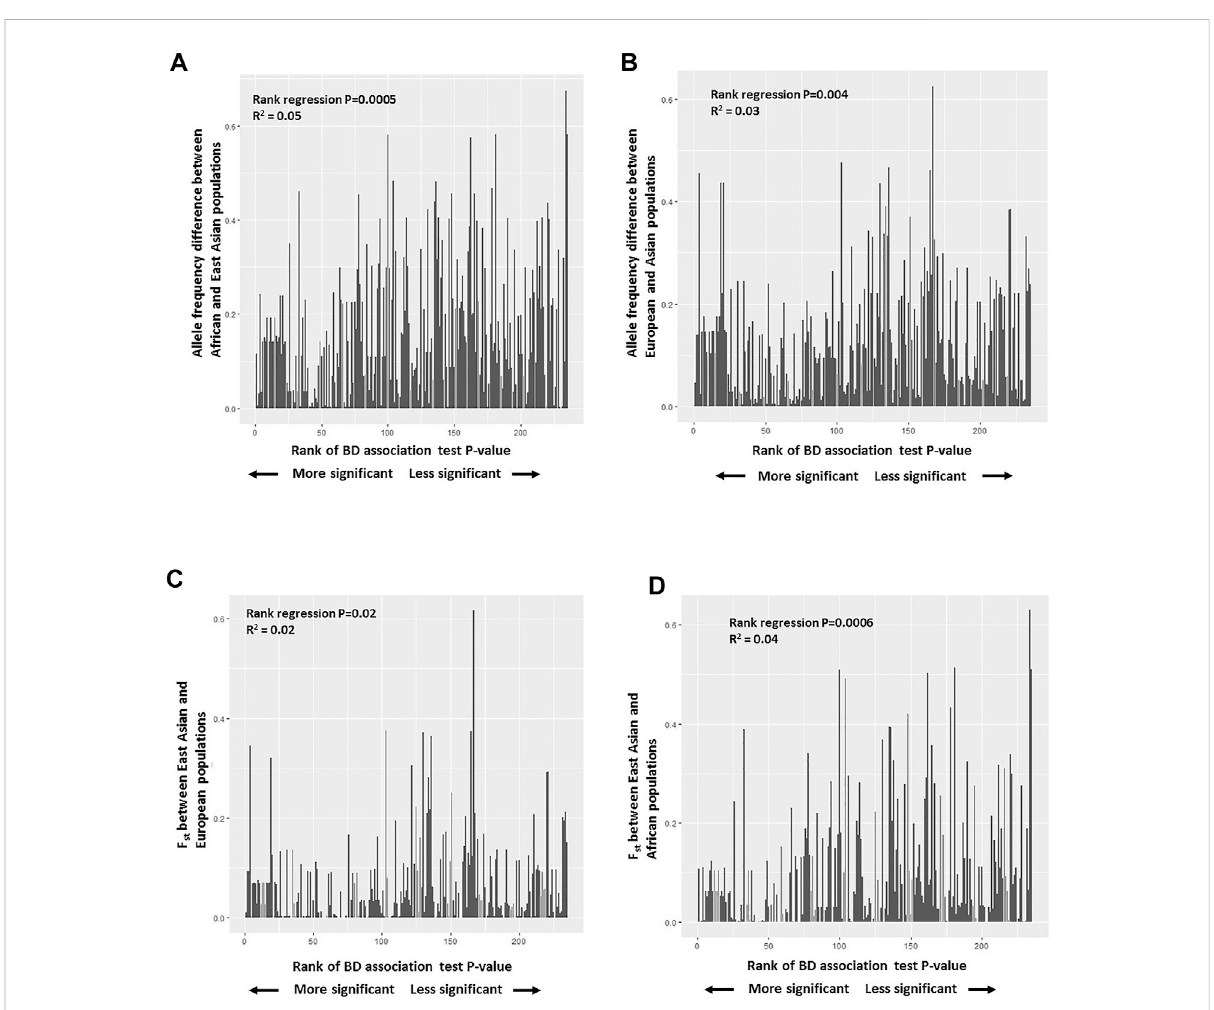
FIGURE 3 (A) Plot of BD associated variants ’ allele frequency difference between African and East Asian populations versus therank of BD association test p -valuesreported. (B) PlotofBDassociatedvariants ’ allelefrequencydifferencebetweenEuropeanandEastAsianpopulationsversustherank ofBD association test p -values reported. (C) Plot of population differentiation (F st ) between East Asian, and European populations versus the rank of BD association test p -values reported. (D) Plot of population differentiation (F st ) between East Asian, and African populations versus the rank of BD association test p -values